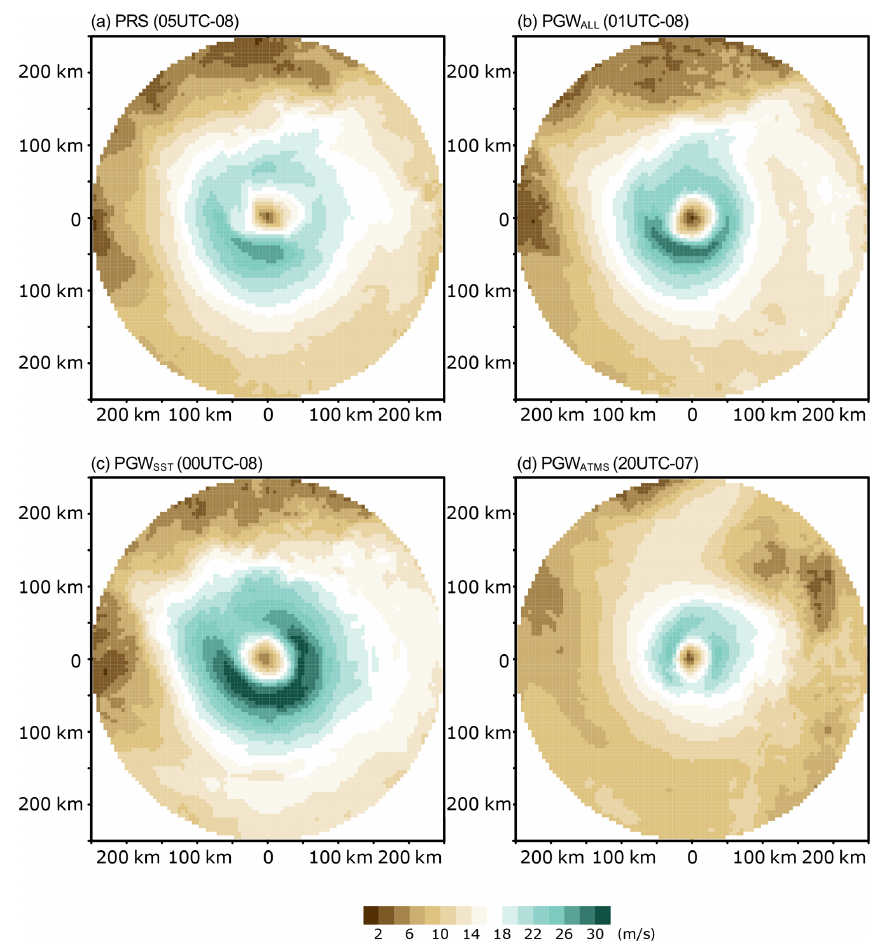
Figure 9. Surface wind speed during maximum wind speed (referring to Fig. 6d) for (a) PRS, (b) PGW ALL , (c) PGW SST , and (d) PGW ATMS around the cyclone